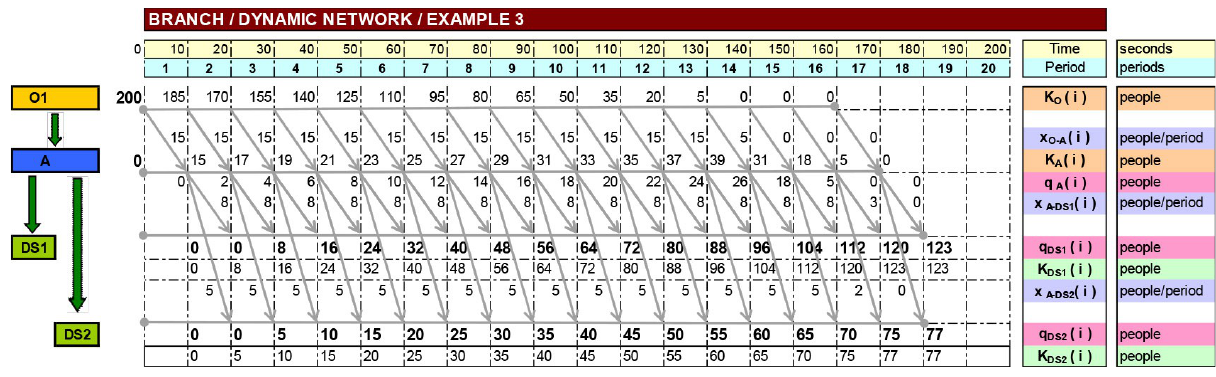
Figure 24. Example of a branch